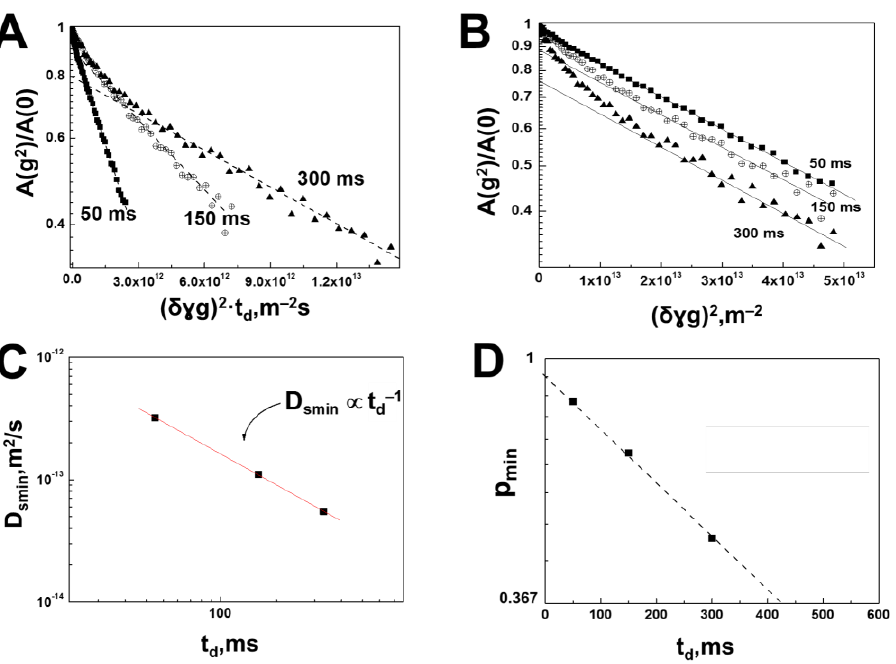
Figure 2. Data for an aqueous solution of HA at a polysaccharide concentration of 0.75%. ( A ) Diffusion decays of the spin echo signal of HA molecules obtained at diffusion times of 50, 150 and 300 ms. The lines show the diffusion decay components characterized by the minimum SDC. ( B ) Diffu- sion decays of the spin echo signal of HA molecules obtained at diffusion times of 50, 150 and 300 ms plotted in coordinates without 𝑡 𝑑 . The lines show the diffusion decay components characterized by the minimum SDC. ( C ) Dependence of the minimum SDC of HA molecules on the diffusion time. The solid line is the slope of 𝑡 𝑑−1 and shows that experimental values of 𝐷 𝑠 are inversely propor- tional to 𝑡 𝑑 . ( D ) Population 𝑝 𝑚𝑖𝑛 (solid squares) with minimum SDC are plotted as functions of diffusion time molecules.